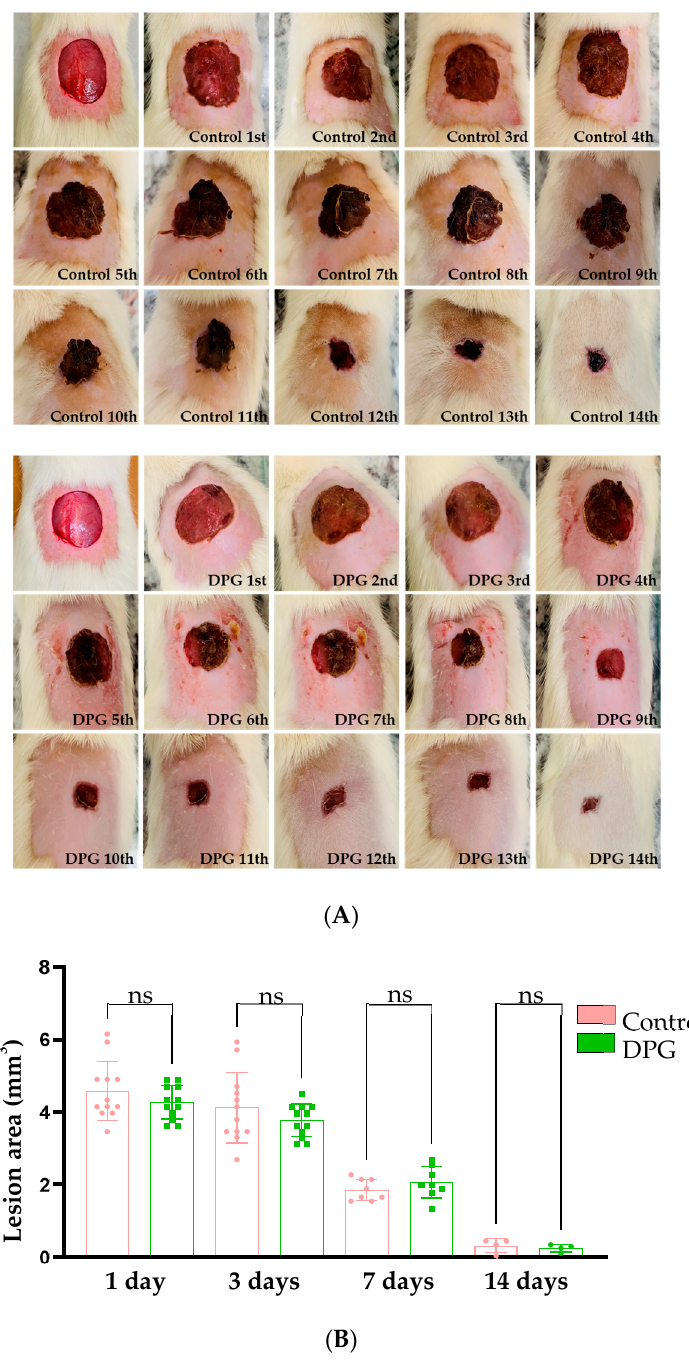
Figure 1. ( A ) Representative macroscopic images of wound healing areas of untreated adult animals (Control—left panel) and those treated with DPG (DPG—right panel) throughout the experimental period (0 to 14 days); ( B ) Quantitative analysis of the measurements of wound healing areas on days 1, 3, 7, and 14, ns—non significant.